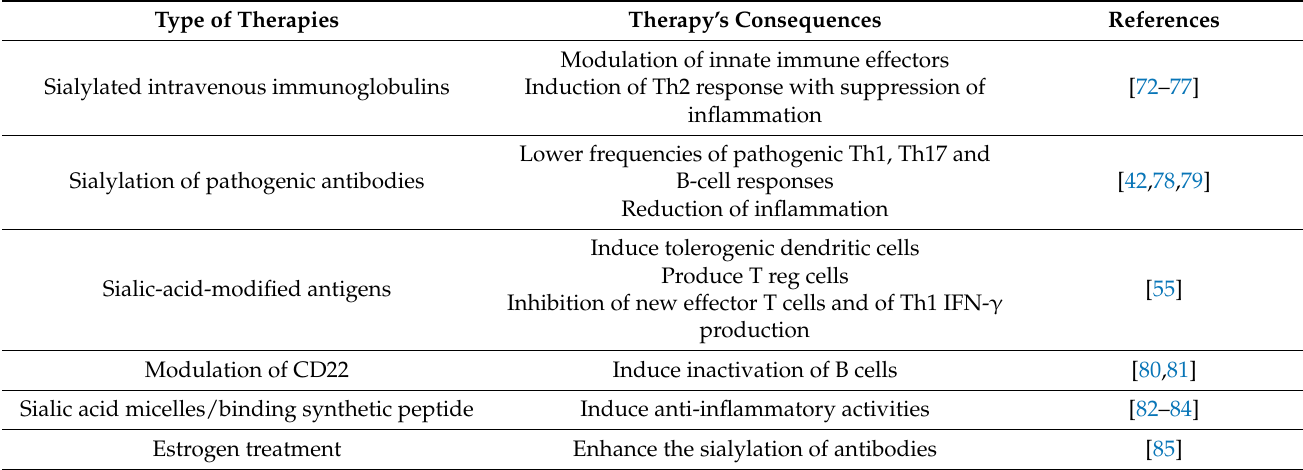
Table 2. Therapies developed in autoimmune